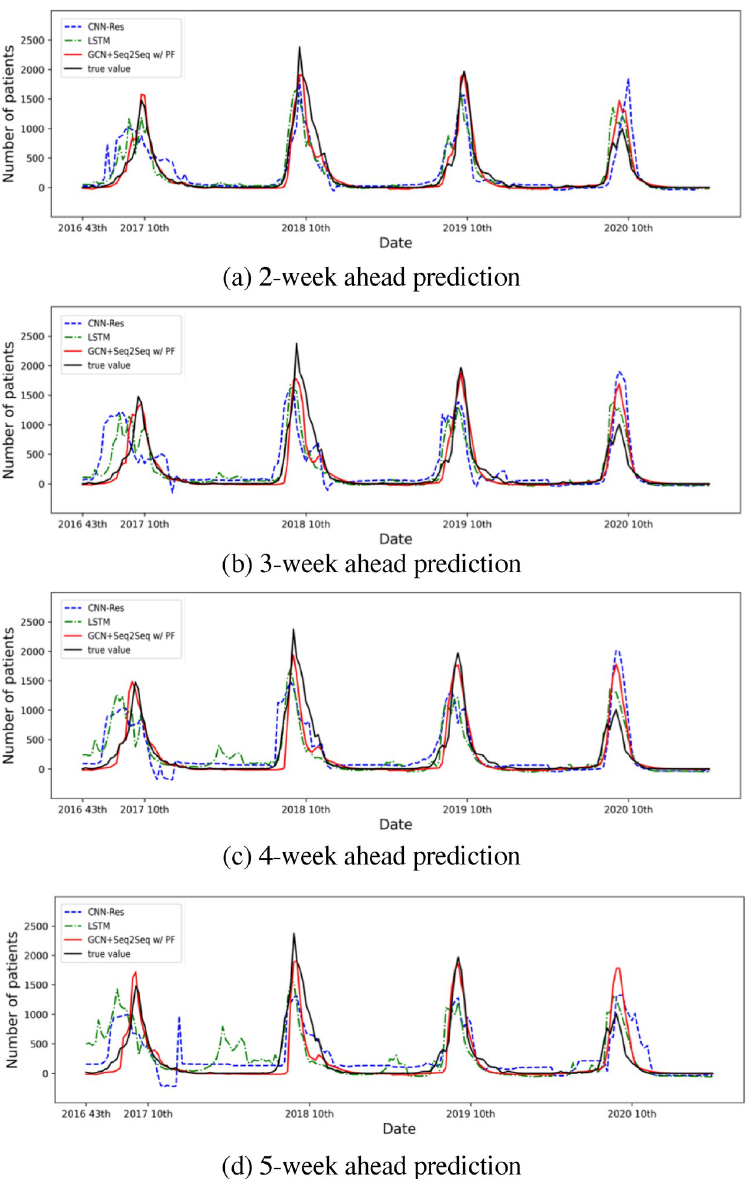
Fig 5. Time series for Okayama prefecture: (a) two weeks in advance, (b) three weeks in advance, (c) four weeks in advance, and (d) five weeks in advance prediction time series in Okayama. The blue and green dotted lines indicate the prediction values of compared models. The red line indicates the prediction values of the proposed GCN+Seq2seq w/ PF model. The black Line indicates the actual influenza